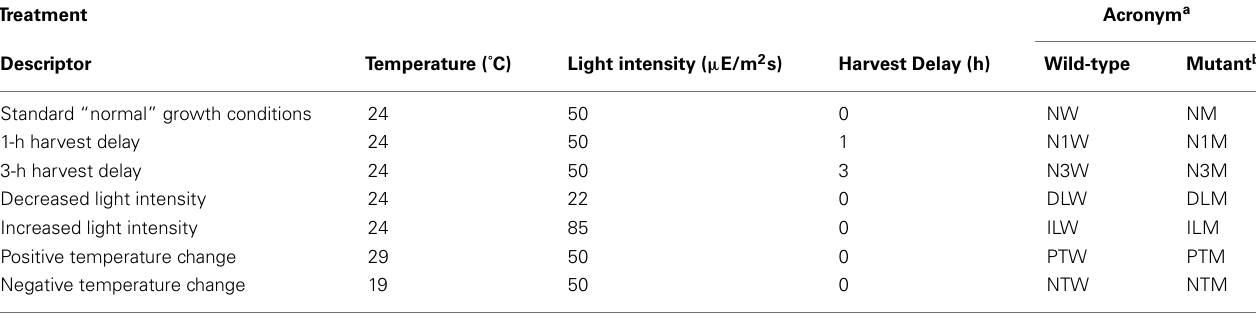
Table 2 | Growth conditions for environmental impact